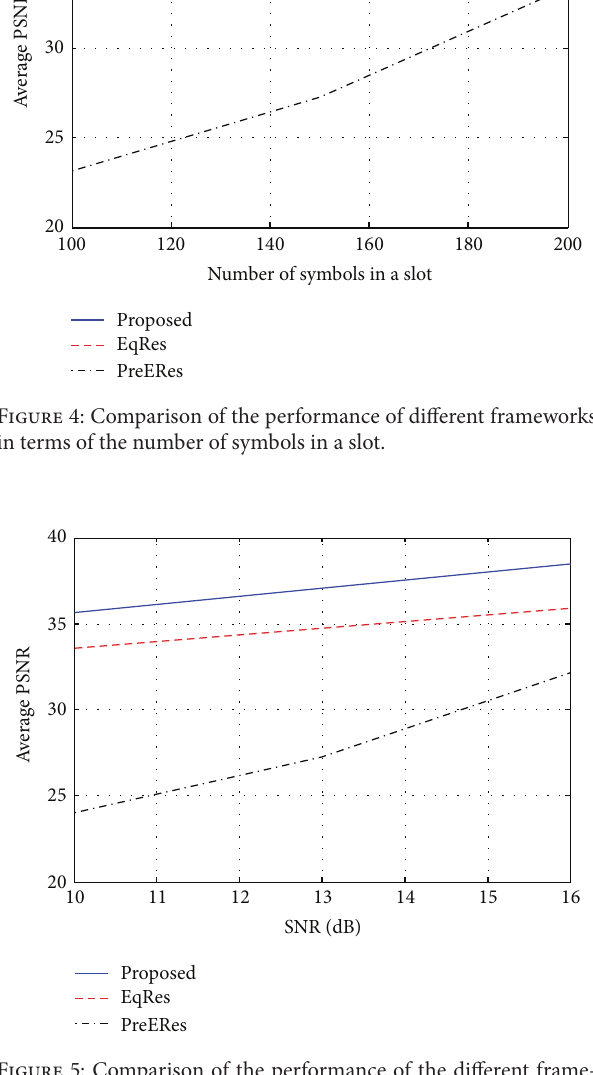
Figure 5: Comparison of the performance of the different frame- works in terms of SNR